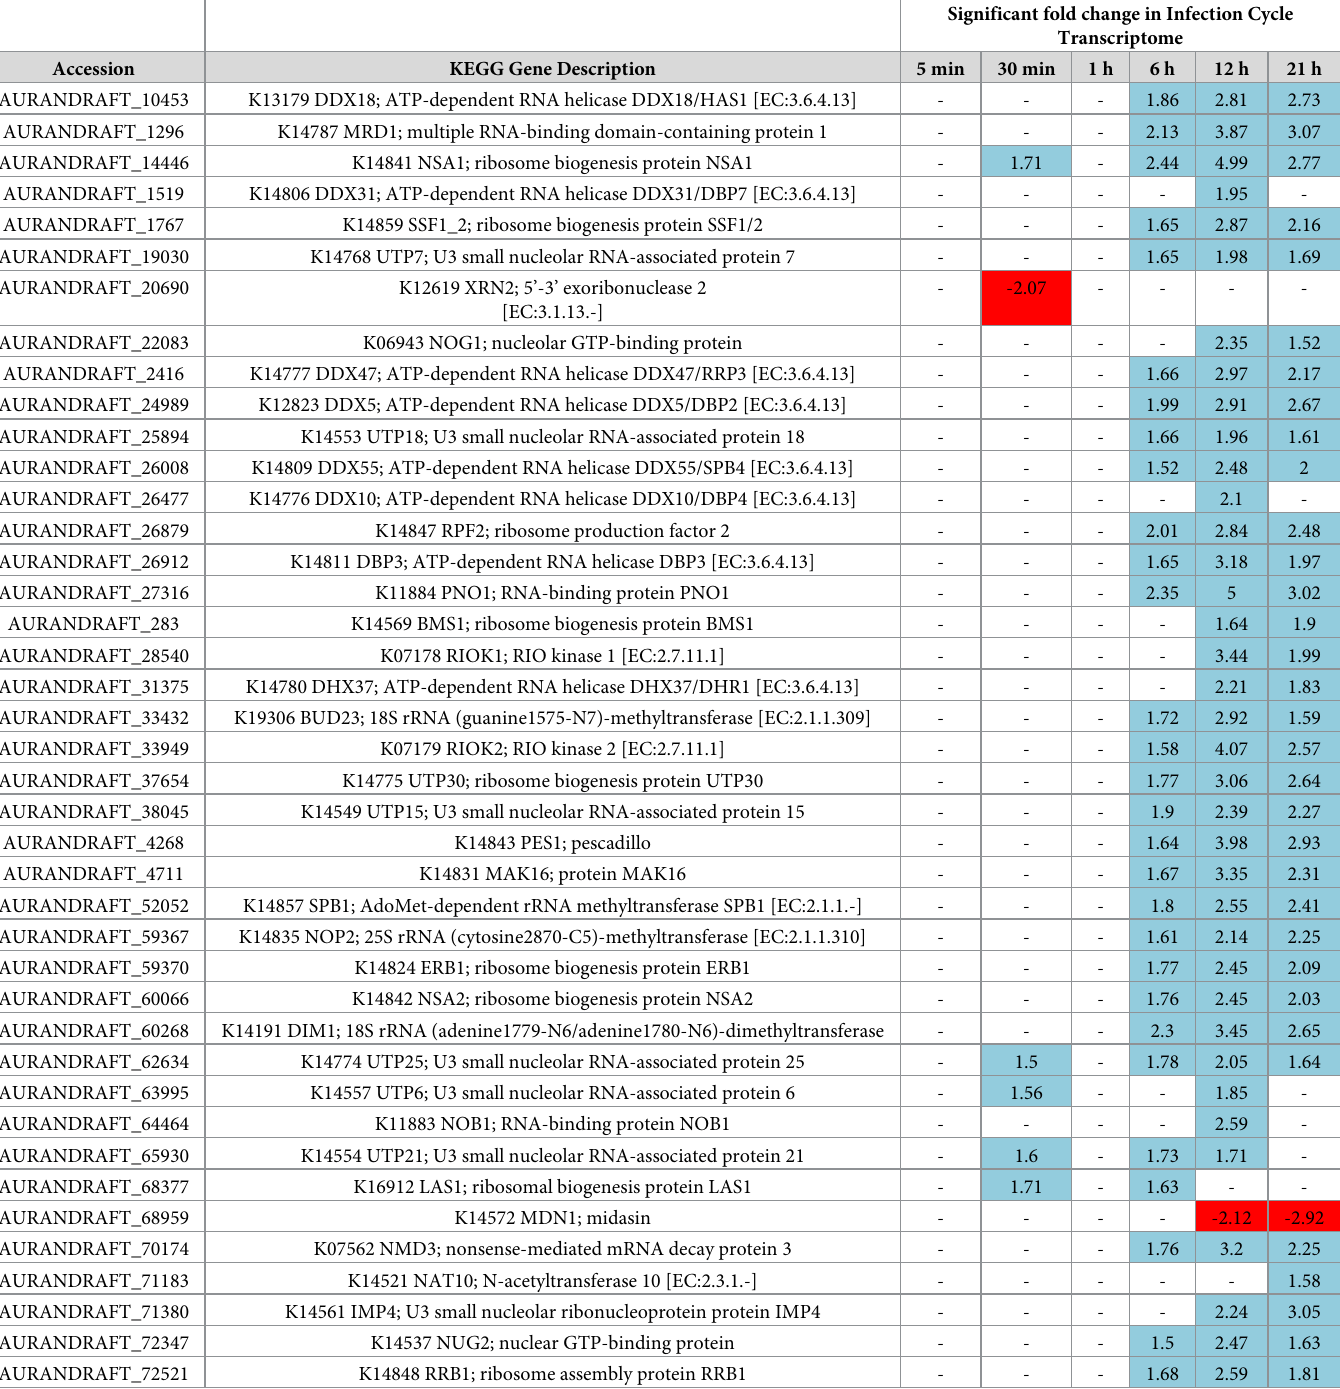
Table 2. Subset of the Aureococcus anophagefferens genes predicted to be significantly downregulated in low light [25] that are related to ribosome biogenesis according to KEGG classifications. Significant fold change values over the course of the infection cycle transcriptome are shown. Significantly overexpressed are in blue while those in red are significantly under